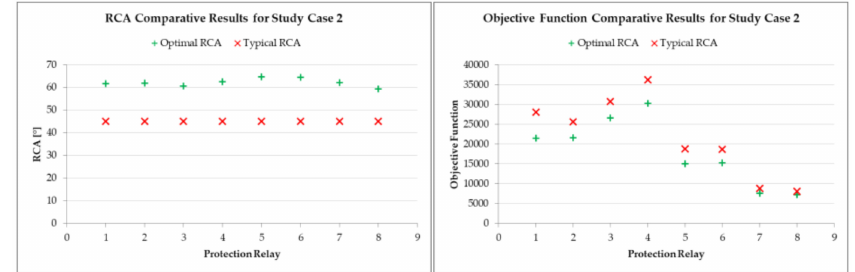
Figure 13. Comparative results for the evaluation of polarization on the directional phase overcurrent element (ANSI 67) in the protection relays of Study Case